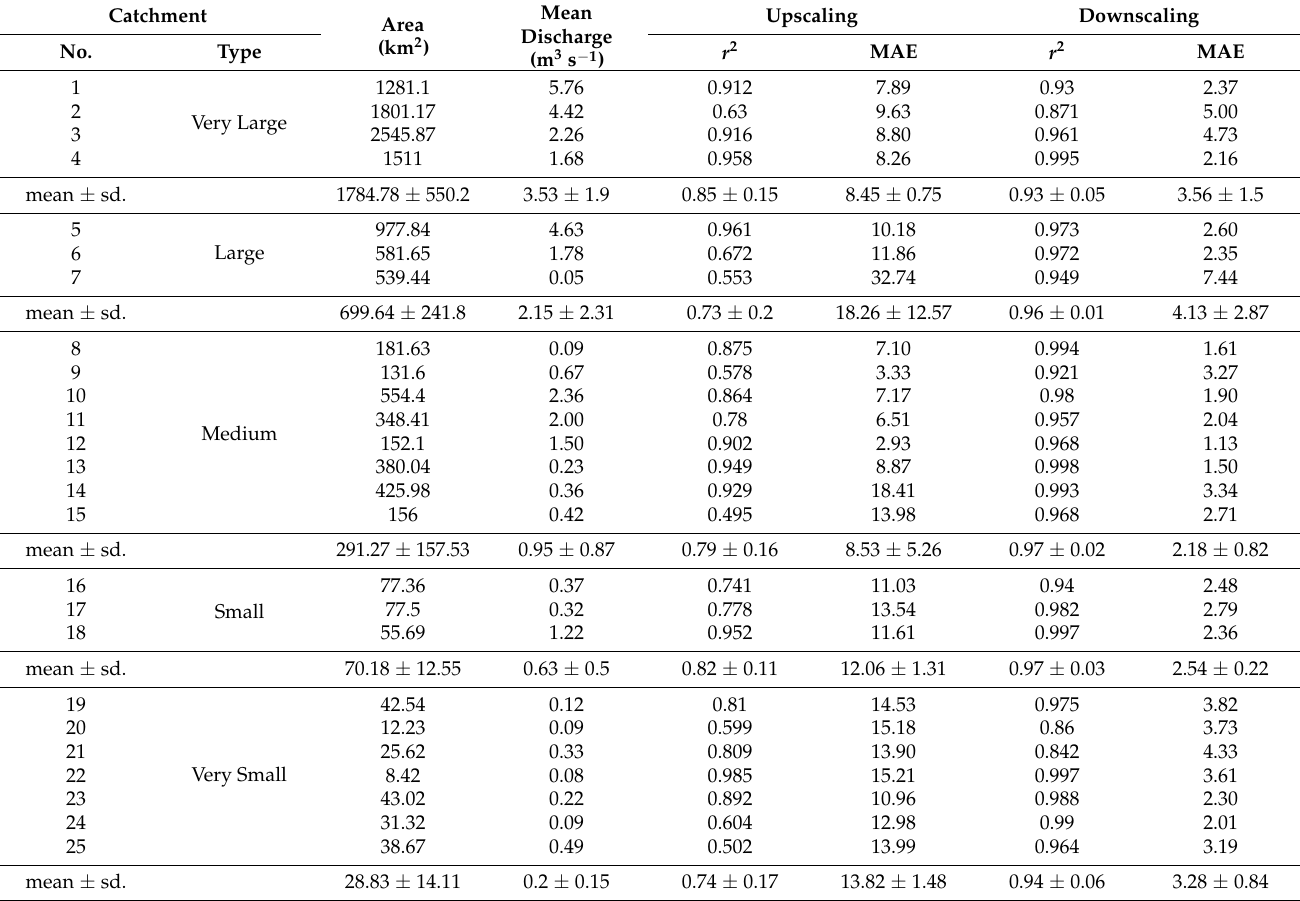
Table 9. Results of the scaling of the ANN CGD training algorithm-based MLR